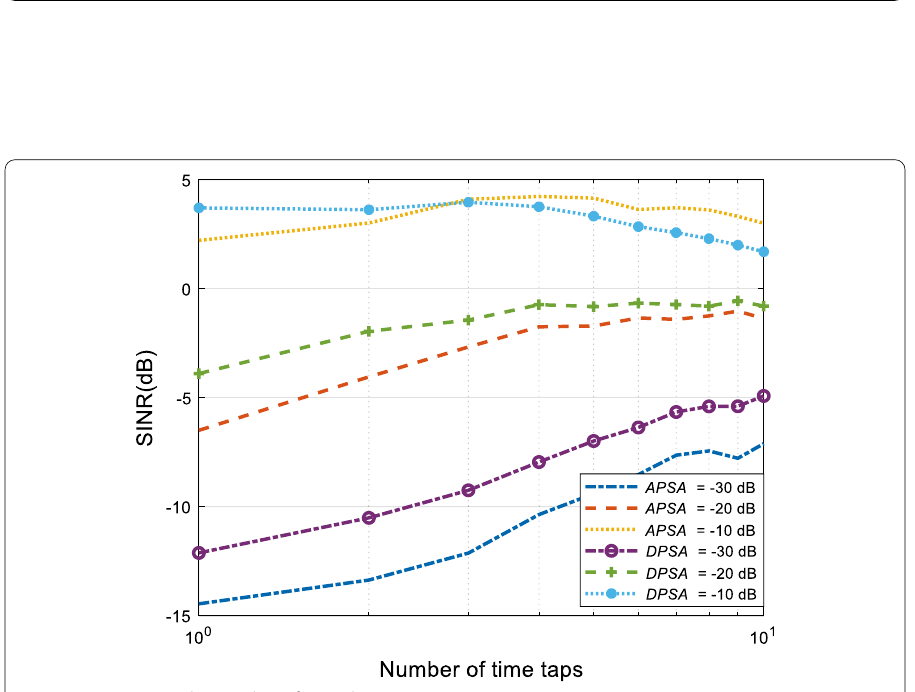
Fig. 10 SINR versus the number of time domain